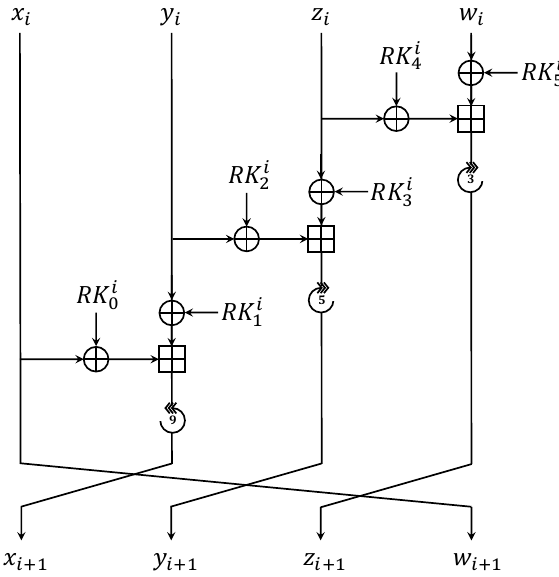
Figure 2. Round function of